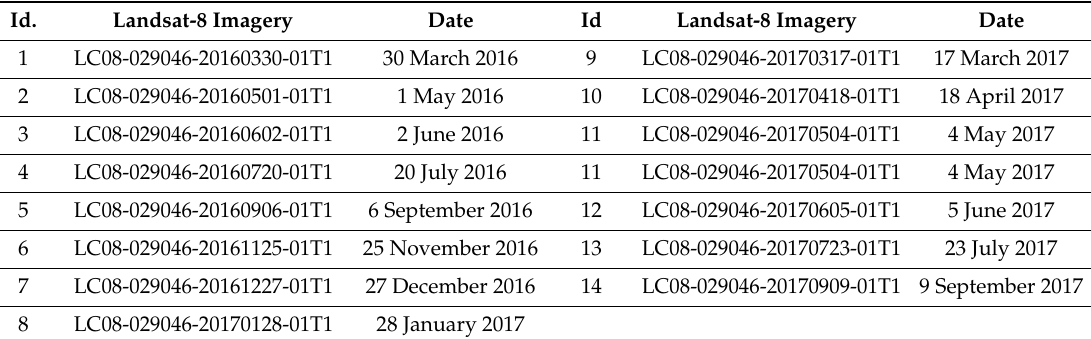
Table 2. List of Landsat-8